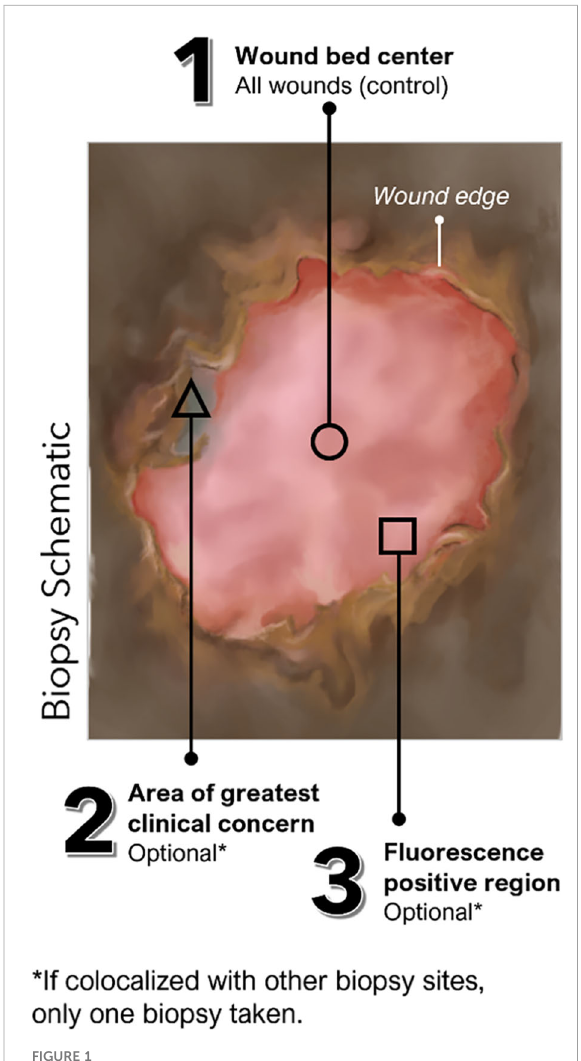
FIGURE 1 Possible locations of tissue biopsies collected in FLAAG